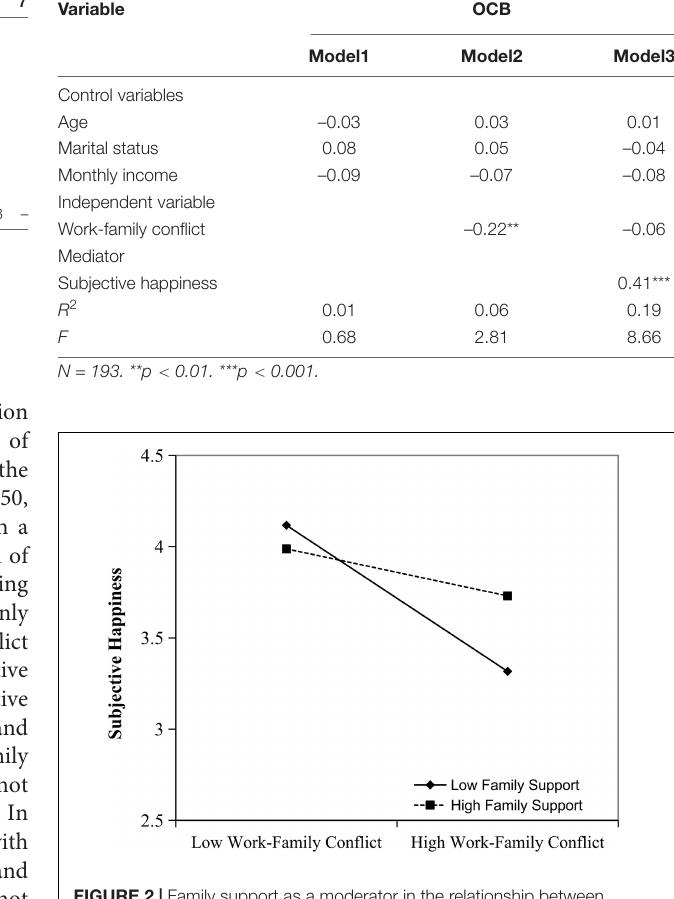
FIGURE 2 | Family support as a moderator in the relationship between work-family conflict and subjective